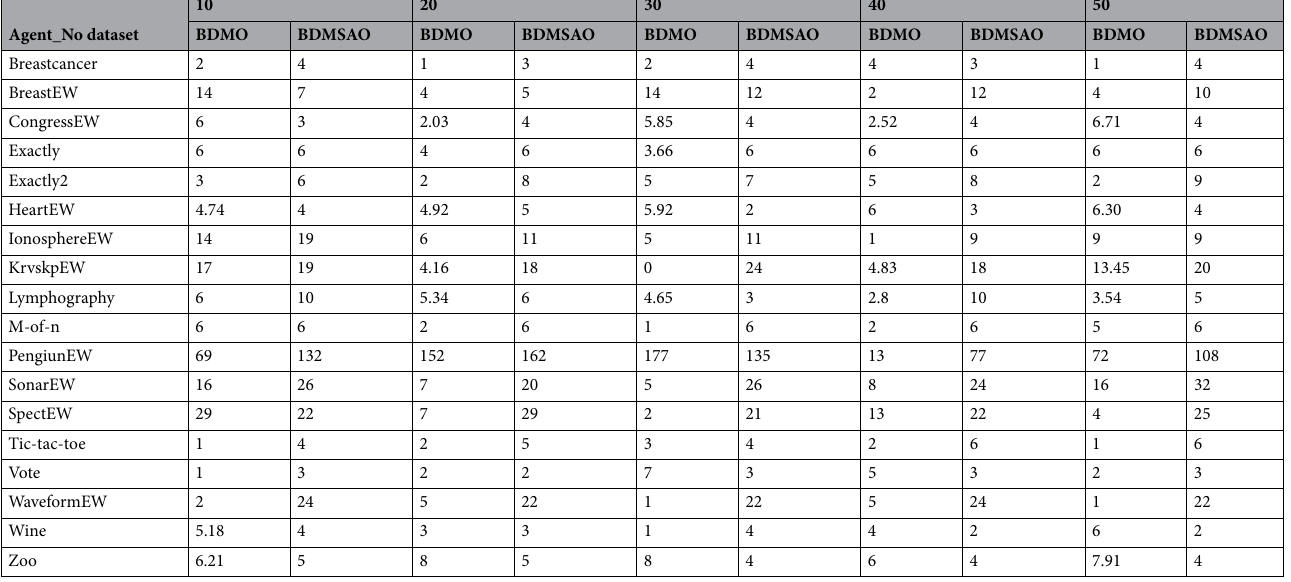
Table 4. Number of features selected by BDMO and